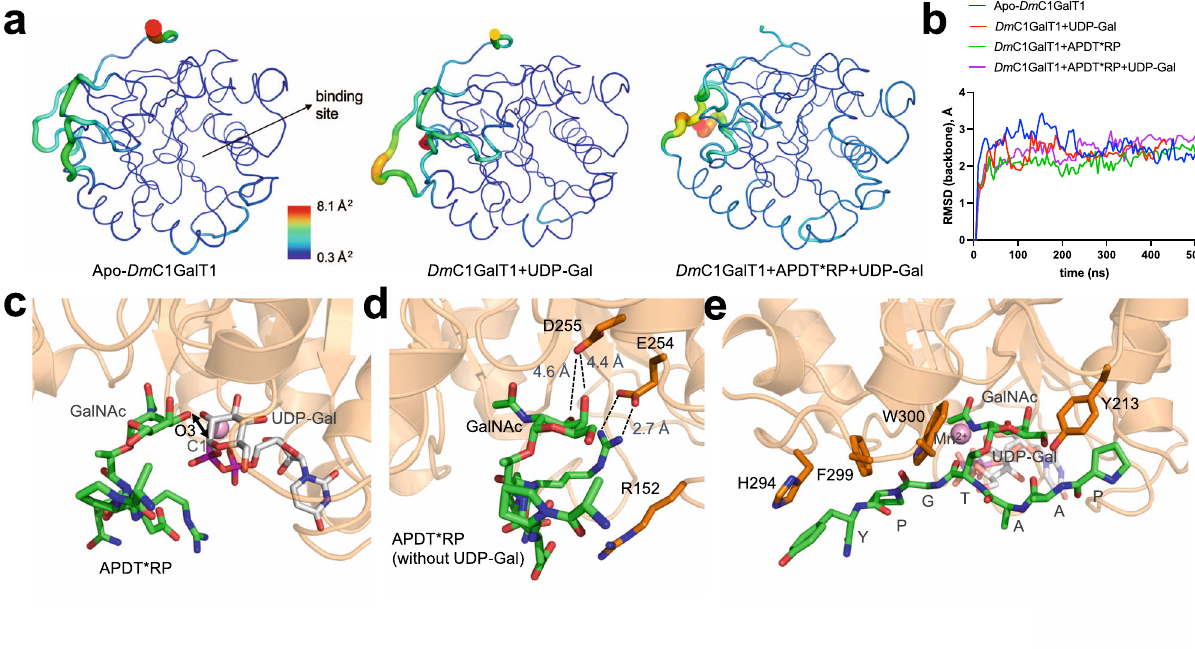
Fig. 6 MD simulations analysis. a Atomic fl uctuation (C α ) derived from 0.5 µ s MD simulations for Dm C1GalT1 and two binary complexes. The data correspond to the average structure of the protein throughout the simulations. b RMSD plots derived from 0.5 µ s MD simulations for the apo form and different complexes. Only the backbone atoms of the protein were used for these calculations. c Close-up view of Dm C1GalT1-UDP-Gal-APDT*RP complex. d Close-up view of the Dm C1GalT1-APDT*RP complex in the absence of UDP-Gal. e Close-up view of the Dm C1GalT1-UDP-Gal-P4 complex, showing the interactions between the protein and the N- and C-terminal regions of the peptide